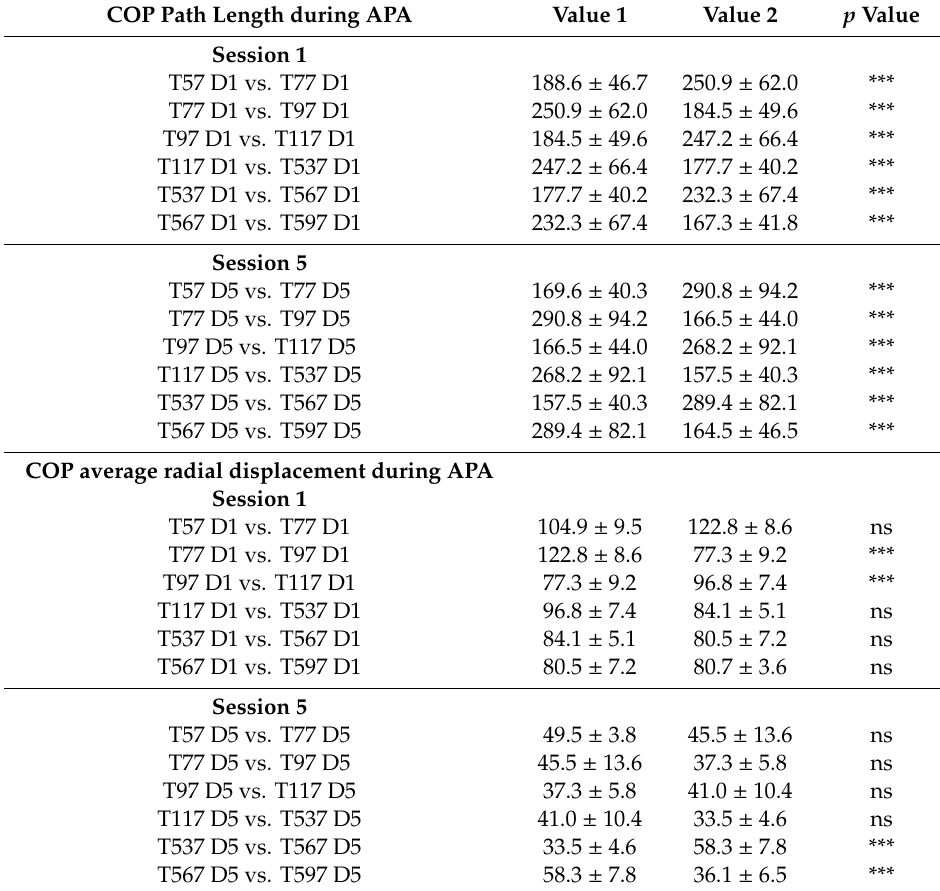
Table 4. Comparison of intrasession COP path length and COP average radial displacement during anticipatory postural adjustment (APA) when pace changes (3 second intervals before changing). Values correspond to means ± SD of the mean. p < 0.001